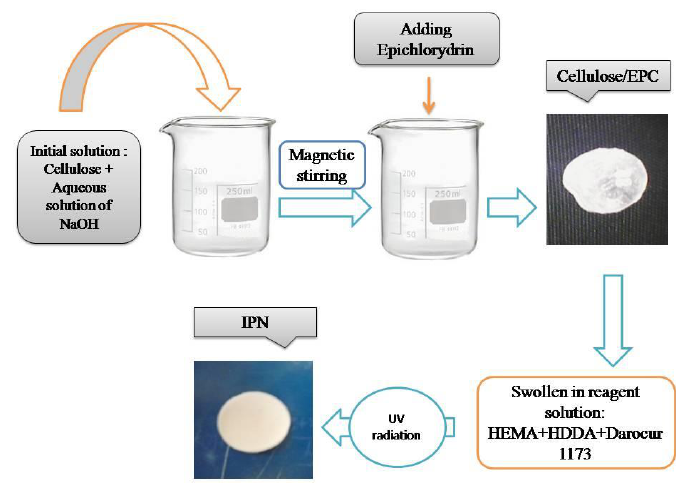
Figure 1. Schematic illustration of the elaboration steps of the cellulose- and PHEMA-based IPN. First, a cellulose solution (200 g) was prepared from 5% ( w / w ) of cellulose, 18% ( w / w ) NaOH (12M) [37] and 77% ( w / w ) distilled water.